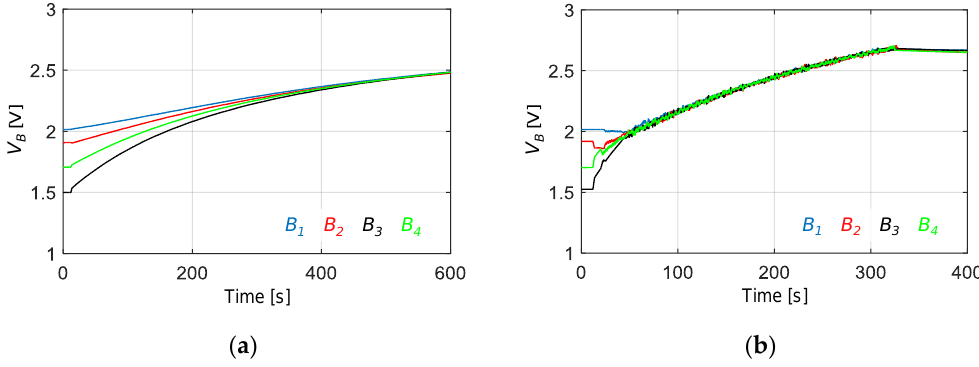
Figure 15. Measured EDLC cell voltage, charged by the open-loop SIMO SC converter. ( a ) With an input source voltage of 3.4 V; and ( b ) with an input source voltage of 5 V.